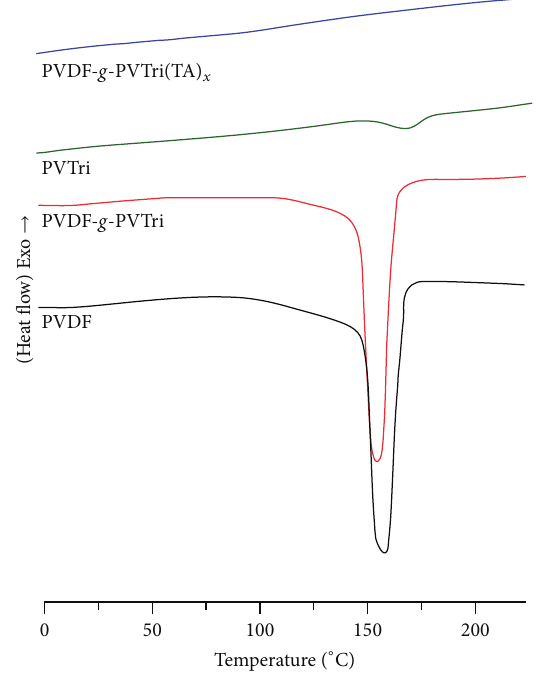
Figure 4: DSC thermograms of PVDF, PVTri, PVDF- g -PVTri, and PVDF- g -PVTri-(TA) 𝑥 ( 𝑥 = 1.0 , 2.0 and 3.0) membranes recorded under N 2 atmosphere at a heating rate of 10 ∘ C/min.